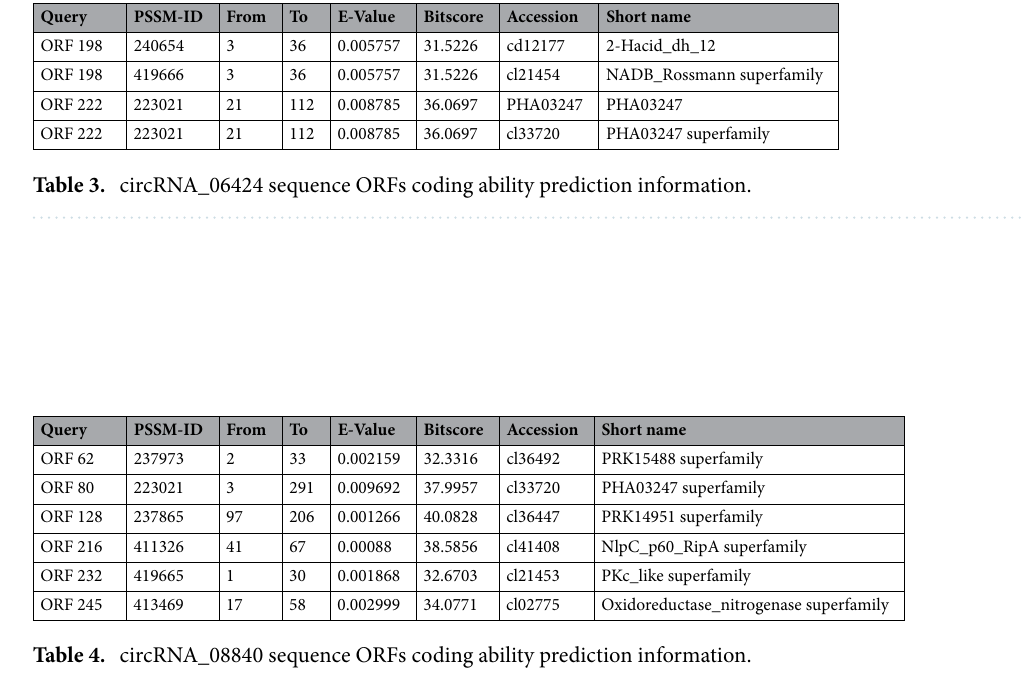
Table 4. circRNA_08840 sequence ORFs coding ability prediction